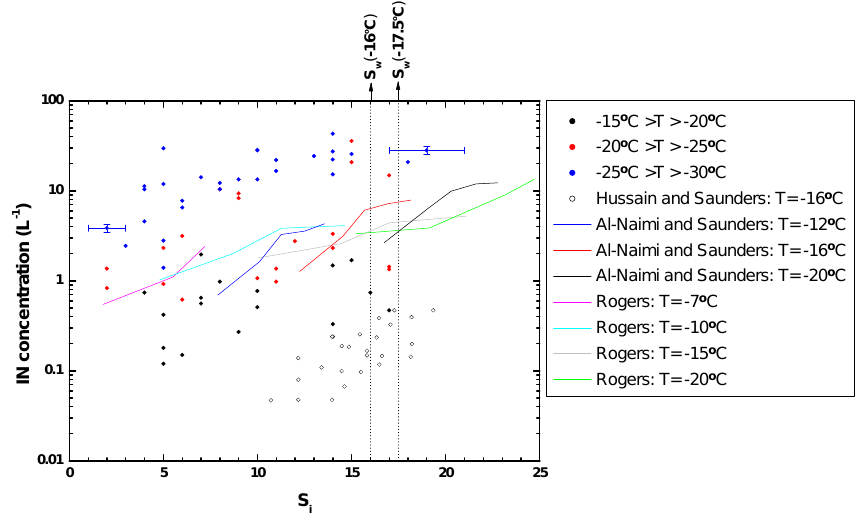
Fig. 6. Data of IN concentration vs. S i , for different temperatures. The present results and those of different authors are represented. Dotted lines indicate the water saturation at different temperatures.